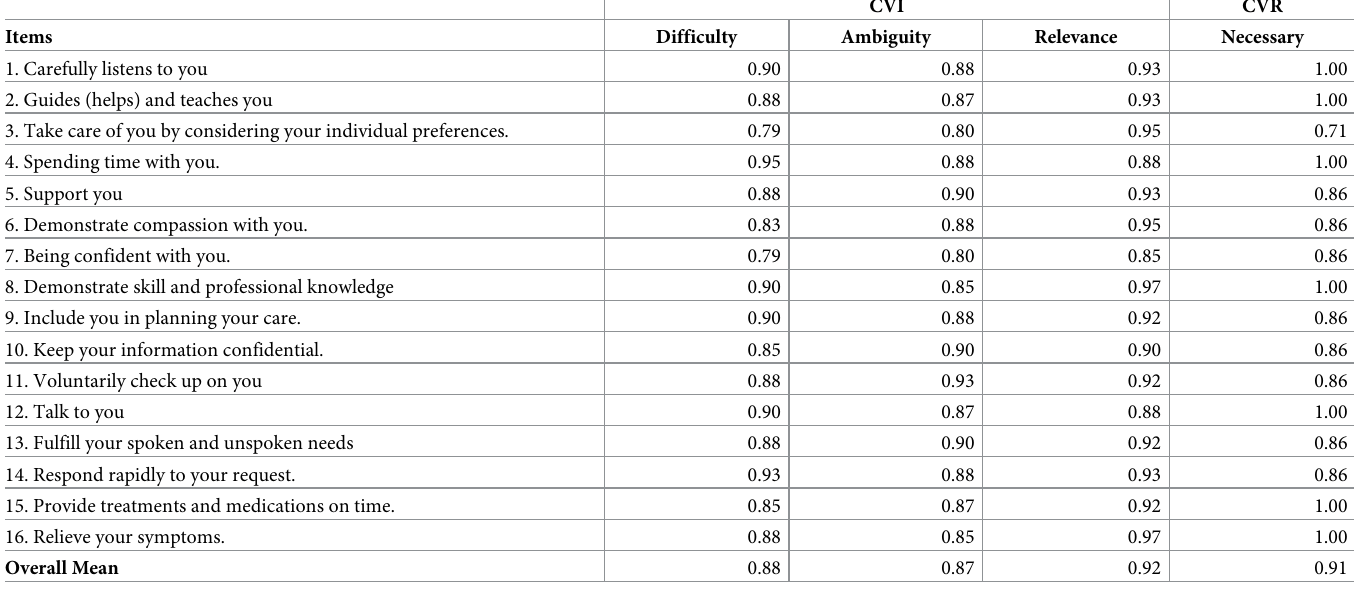
Table 3. The 16-item CBI and the reported CVI and